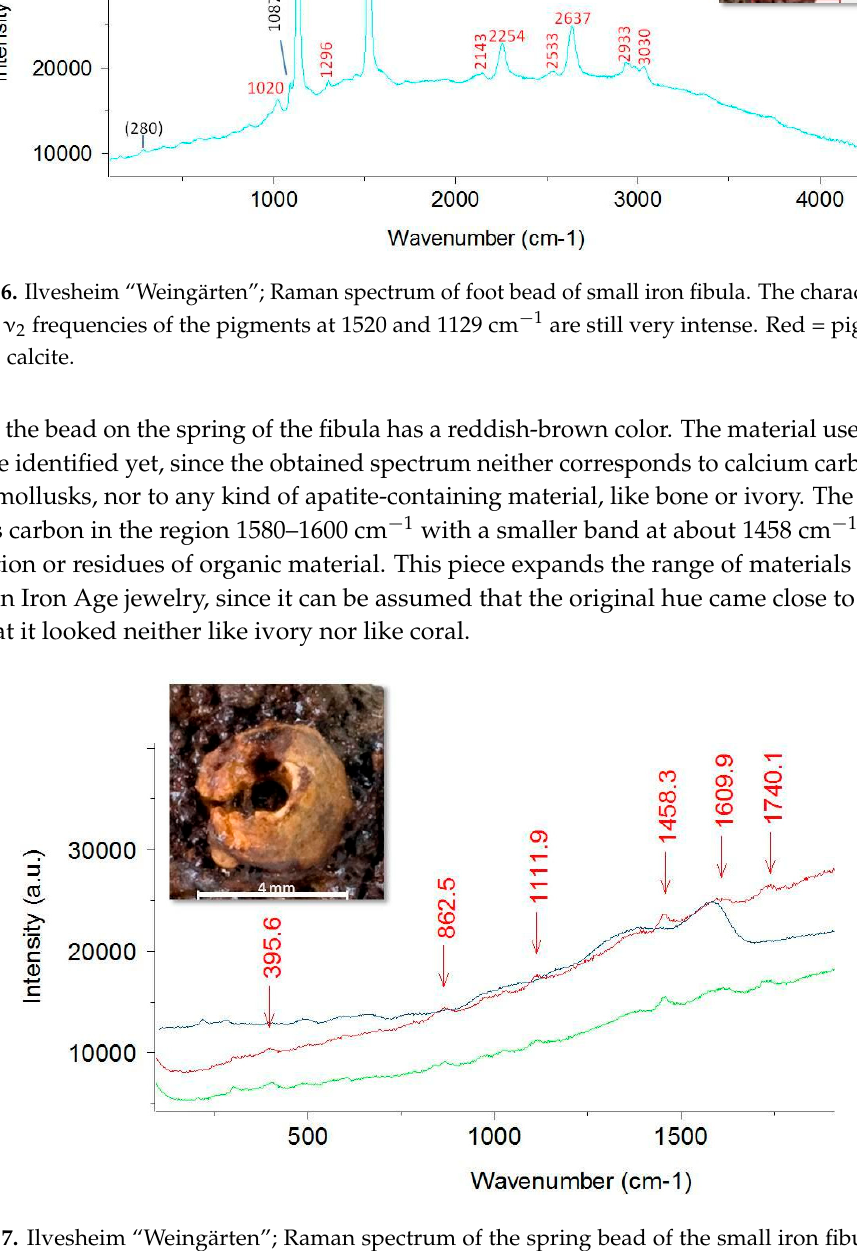
Figure 7. Ilvesheim “Weingärten”; Raman spectrum of the spring bead of the small iron fibula (see Figure 8). The presence of amorphous carbon in the region 1580–1600 cm − 1 with a smaller band at about 1340 cm − 1 indicates a contamination or residues of organic material.